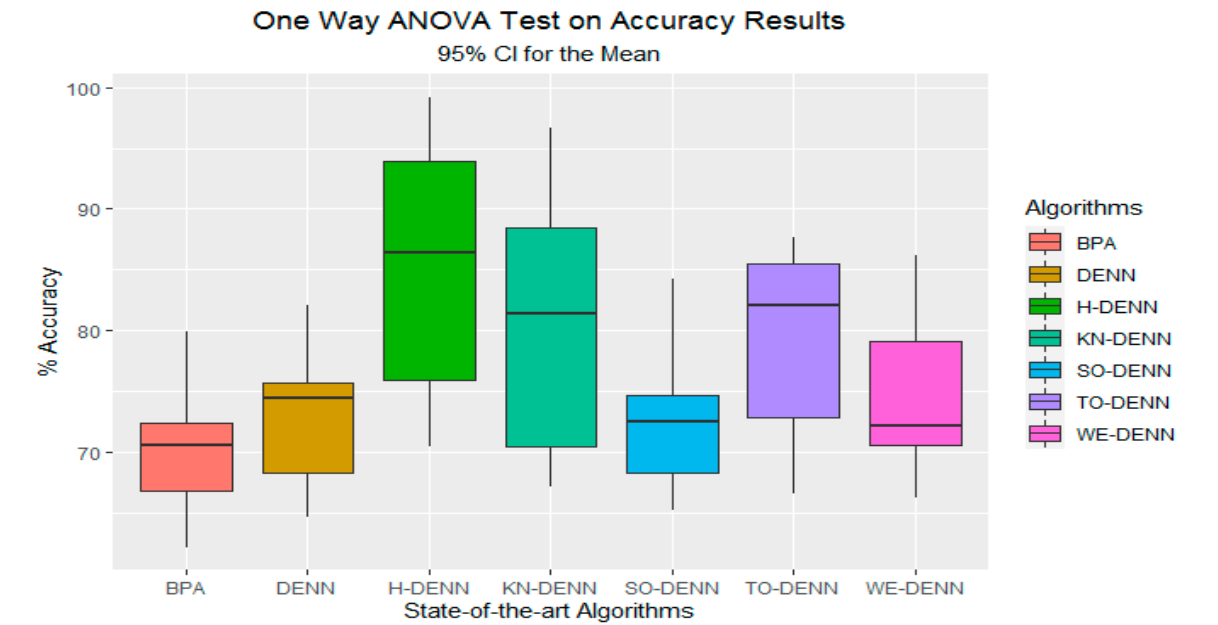
Figure 44. Multicomparison post hoc Tukey test graph of DE variants.